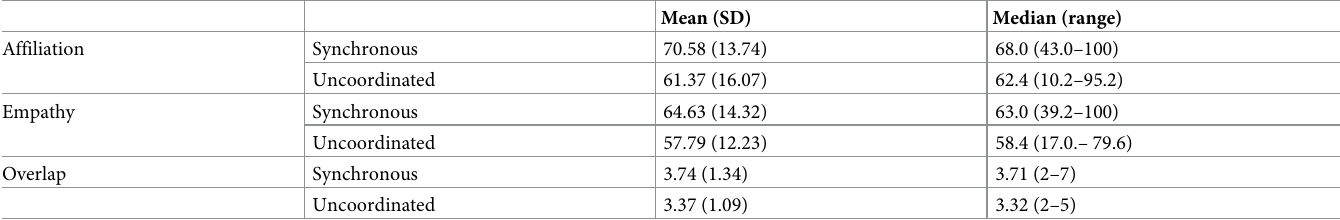
Table 2. Descriptive statistics for the total Affiliation, Empathy and Overlap ratings towards the